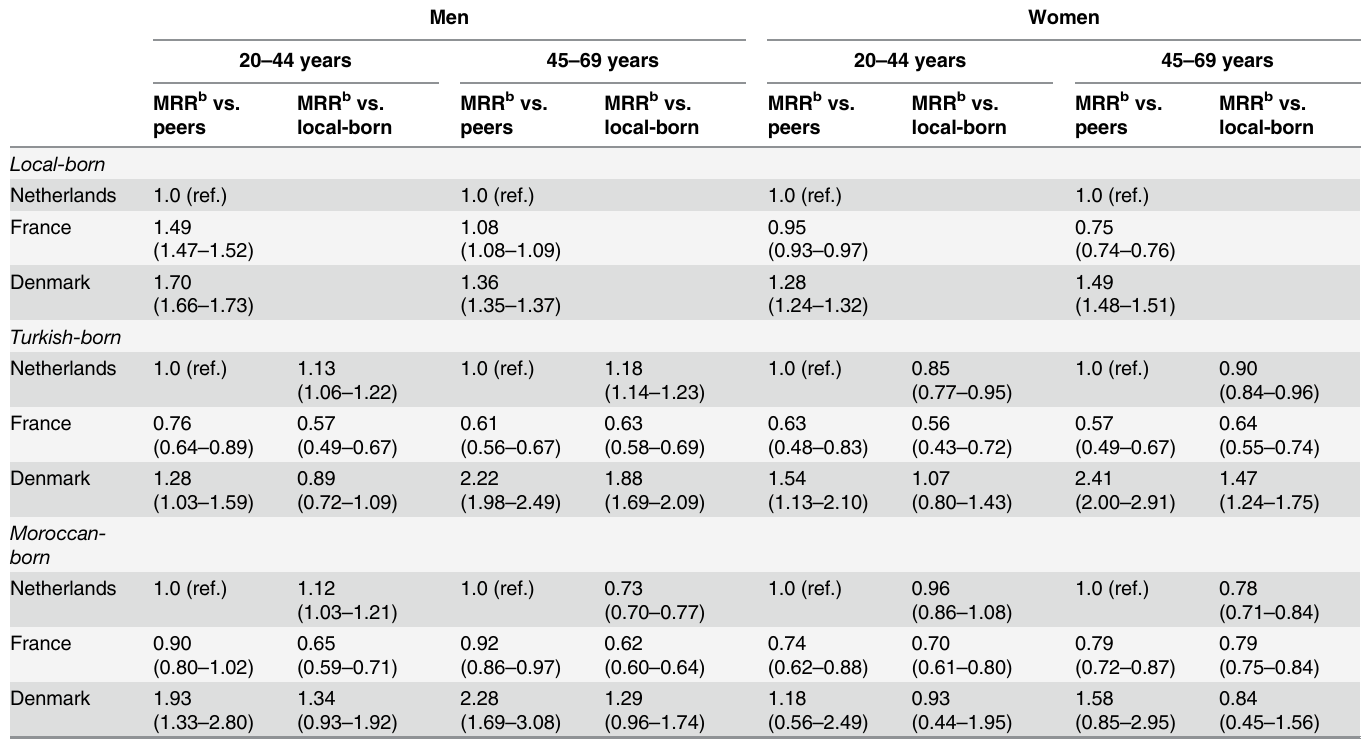
Table 3. All-cause mortality rate ratios (MRRs) with 95% confidence intervals in Turkish- and Moroccan-born immigrants in three European coun- tries, compared with the local-born population a and with peers in the Netherlands, stratified by sex and age